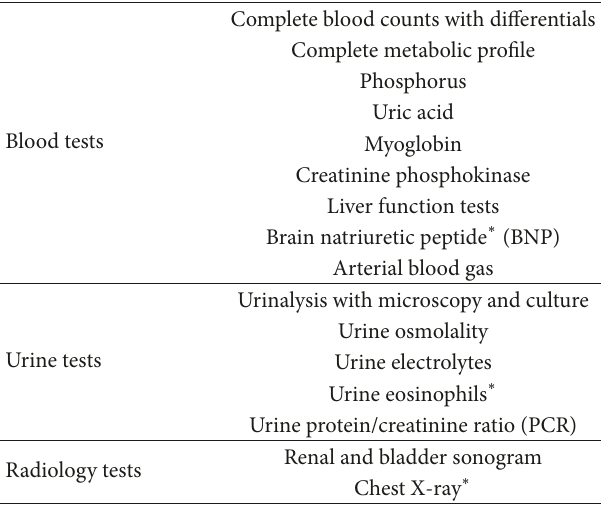
Table 1: Basic investigation for acute renal failure ( ∗ tests can be ordered if needed based on history and